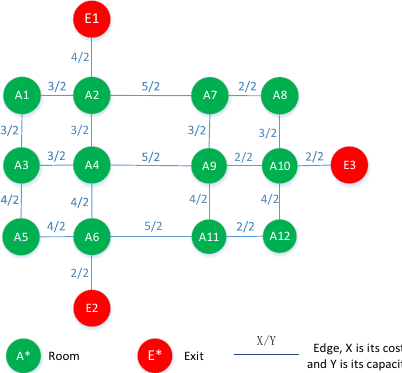
Figure 1. The indoor network with multiple exits.